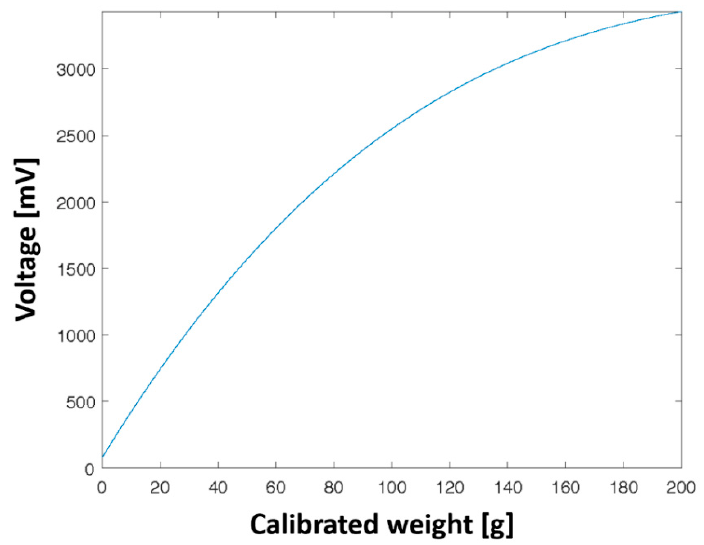
Figure 3. FSRs experimental characterization curve expressed as applied calibrated weight vs. ADC input voltage.